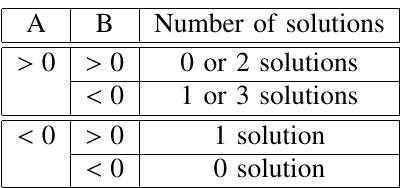
E xistence of solutions of equation